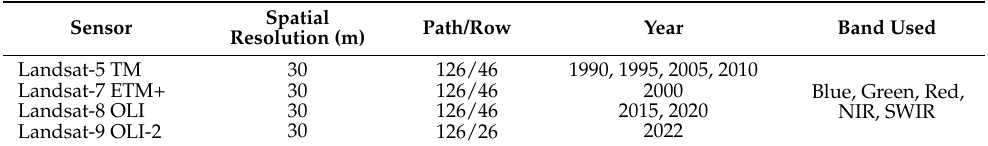
Table 1. Time-series Landsat imagery used for 32 years in the study area. Sensor Spatial Resolution